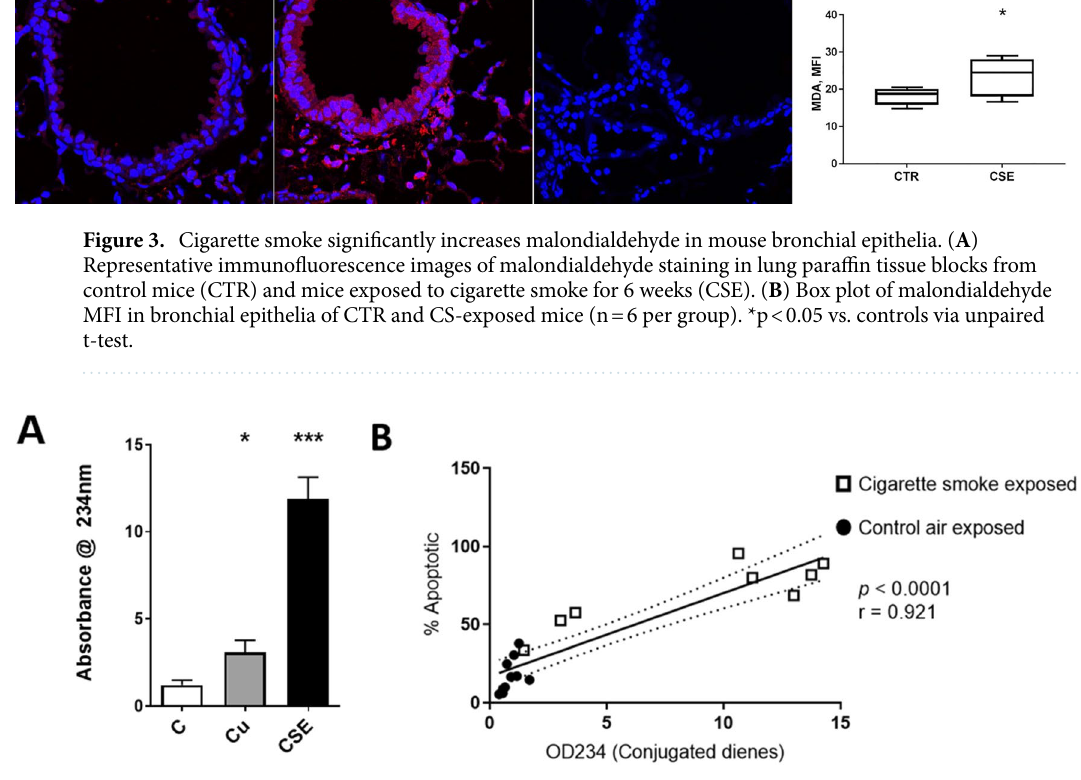
Figure 4. Cigarette smoke extract induces oxidised lipids from bronchial epithelial cells. ( A ) Relative levels of lipid oxidation in CSE-treated HBE cells measured by absorbance at 234 nm (peak absorbance of conjugated dienes); copper (Cu) was used as an oxidation control. Data represents mean ± SEM, n = 6–10, * p < 0.05, *** p < 0.005, Wilcoxon signed ranks test. ( B ) Spearman correlation of lipid oxidation (by OD234 measurement) and percentage of apoptotic